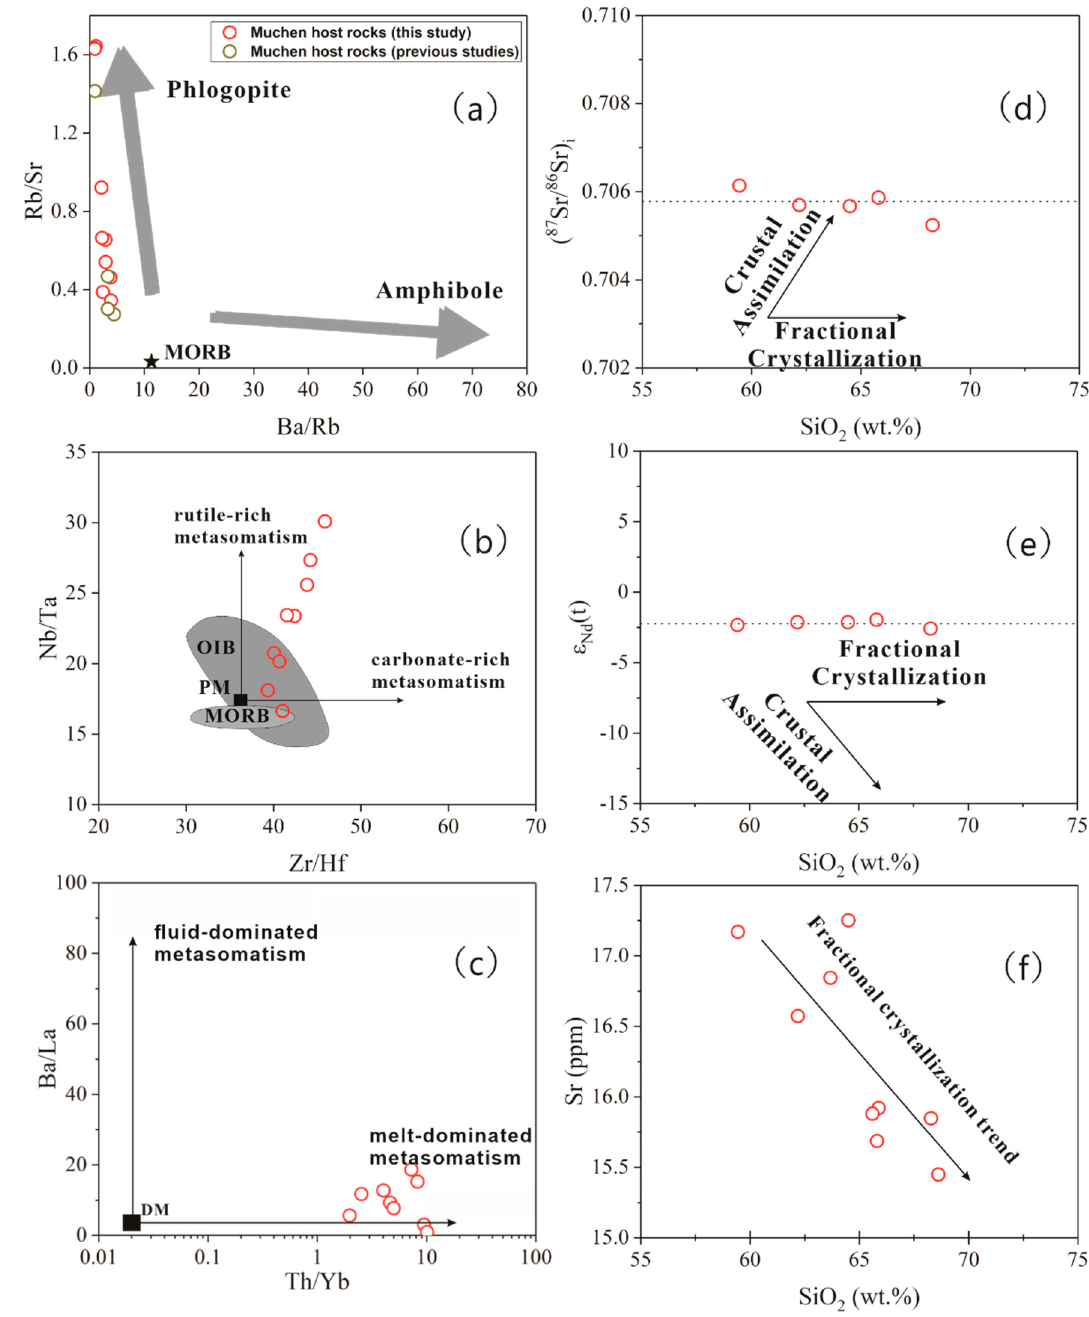
Figure 14. ( a ) Rb / Sr vs. Ba / Rb; ( b ) Zr / Hf vs. Nb / Ta diagram (Guo et al., 2004); ( c ) Th / Yb vs. Ba / La diagram [104]; ( d ) SiO 2 vs. ( 87 Sr / 86 Sr) i ; ( e ) SiO 2 vs. ε Nd (t); ( f ) SiO 2 vs. Sr. Data source: Primitive Mantle (PM) and mid-oceanic ridge basalt (MORB) [74]; Ocean Island Basalt (OIB) [101,108]; Depleted Mantle (DM) [109]. Previous data of Muchen [30].